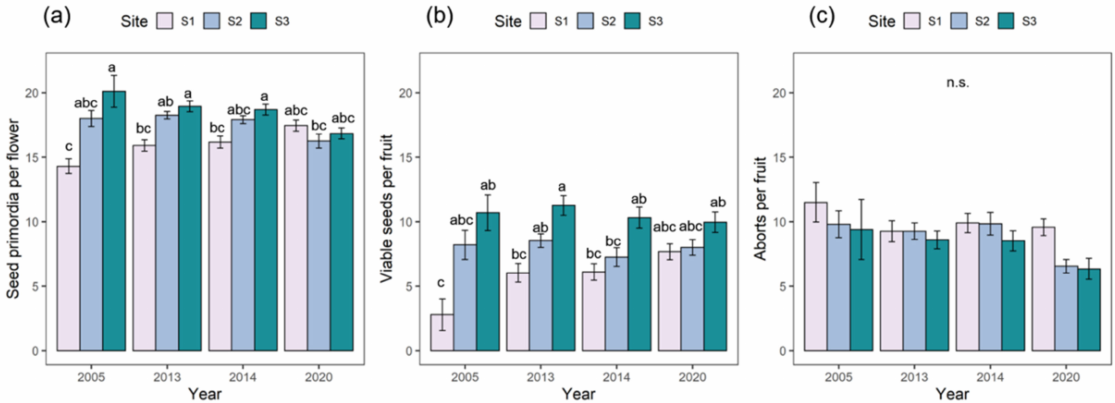
Figure 2. ( a ) Means of seed primordia per flower, ( b ) viable seeds per fruit, and ( c ) aborts per fruit by studied site over time ( ± SE). Different letters represent significant differences between sites at p < 0.01 in the post hoc Tukey tests after GLMs.